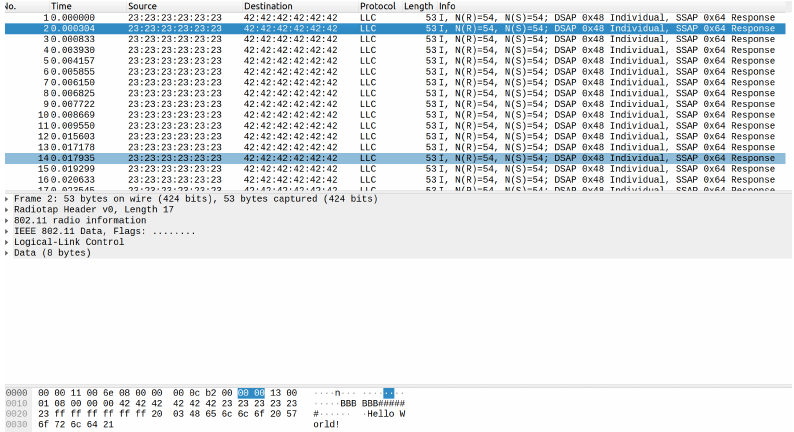
Figure 13. Example communication via 802.11p on Wireshark with test string “Hello World!”. The same string was continuously transmitted using the Message Strobe